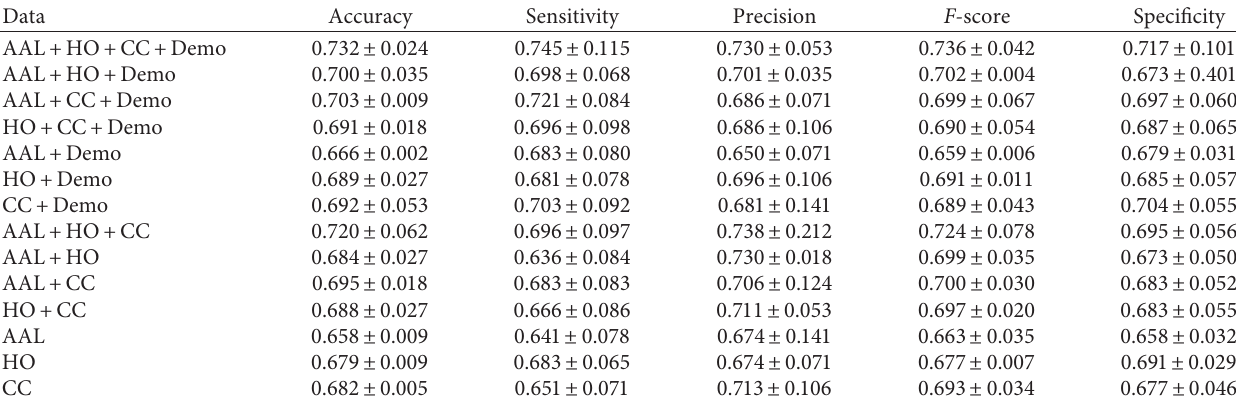
Table 4: Comparison of multichannel DANN on different data combinations using 10-fold cross validation on the entire dataset. Data Accuracy Sensitivity Precision F